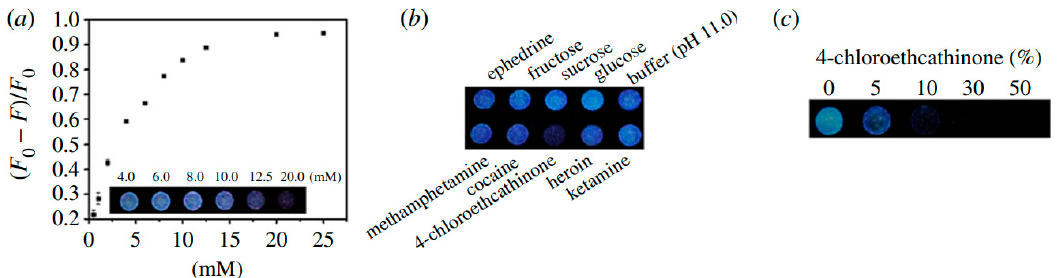
Figure 18. Quenching of fluorescence of C-dot-impregnated paper at pH 11, under a 254 nm portable light: ( a ) by varying concentrations of 4-chloroethcathinone; ( b ) by a range of related compounds and common diluents (cocaine, heroin and ketamine are at saturation, other compounds at 25 mM), showing clear selectivity for 4-chloroethcathinone; ( c ) at di ff erent w / w % in the presence of glucose. Reproduced with permission from reference [79], Royal Society Open Science; published by The Royal Society Publishing,